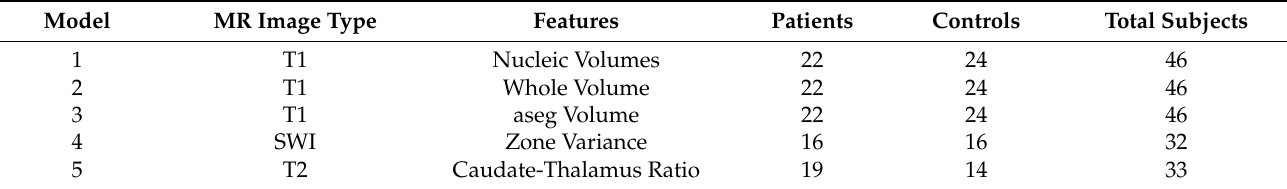
Figure 1. MR images of an AGU patient ( A – C ) and an age- and sex-matched healthy control ( D – F ). ( A , D ) T1-weighted image with segmented thalamic nuclei. ( B , E ) Susceptibility weighted image with the outlines of the segmented thalamus. ( C , F ) T2-weighted image with the outlines of the segmented thalamus and the caudate. Table 2. Details of the models and number of data points used for the